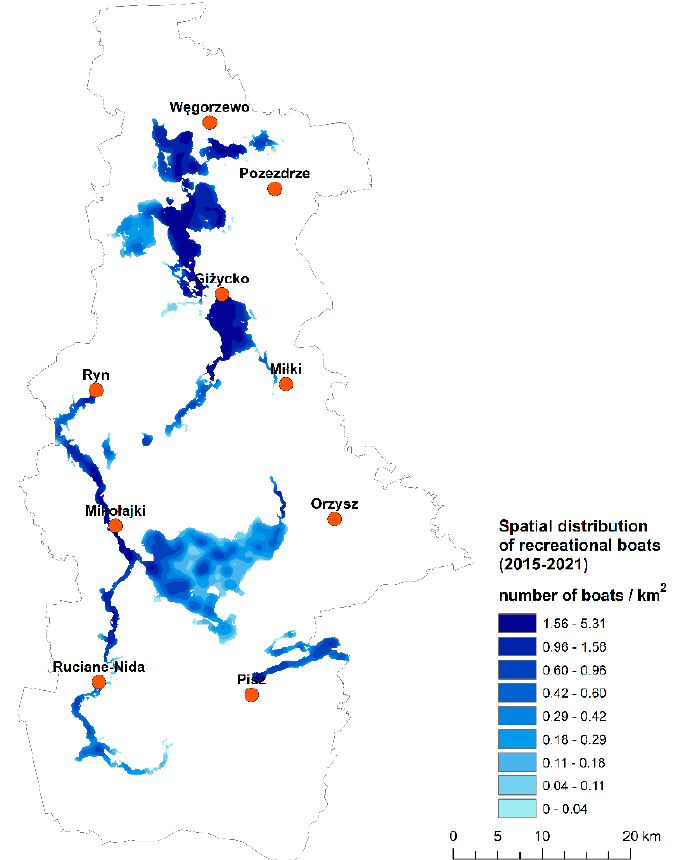
Figure 7. Spatial and temporal distribution of detected recreational boats for the period 2015–2021. Table 5. A correlation among the spatial distribution of